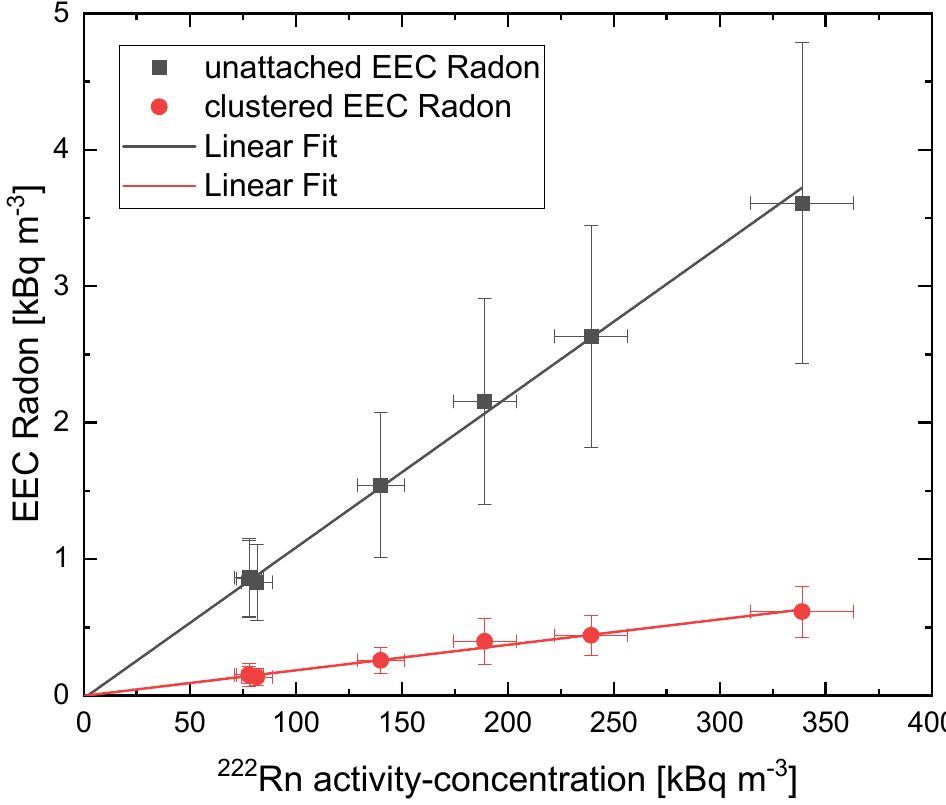
Figure 4. Relationship between radon activity concentration and unattached (grey) and clustered (red) equilibrium equivalent concentrations. The solid line represents a linear fit; the uncertainty was weighted by 1 σ − 2 , with σ being the size of the error bar obtained by the measurement device. The fit was performed using the software Origin. It represents a linear regression with an R 2 of 0.99 for the unattached fraction and R 2 of 0.98 for the clustered fraction, confirming a linear relationship.